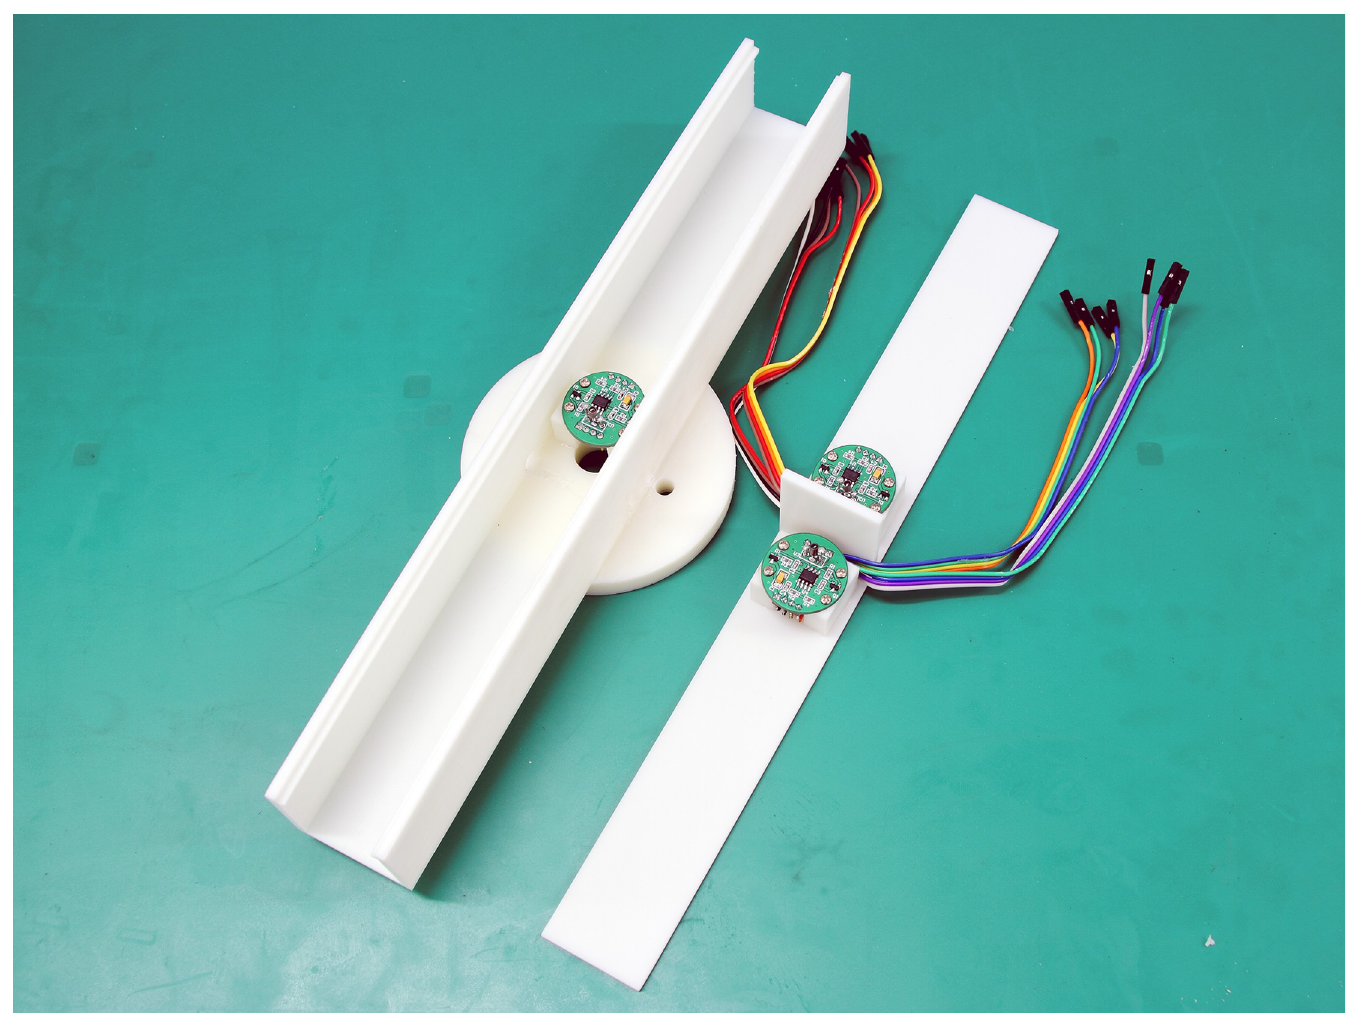
Fig 8. Image of airflow tunnel, damper board, and wind velocity